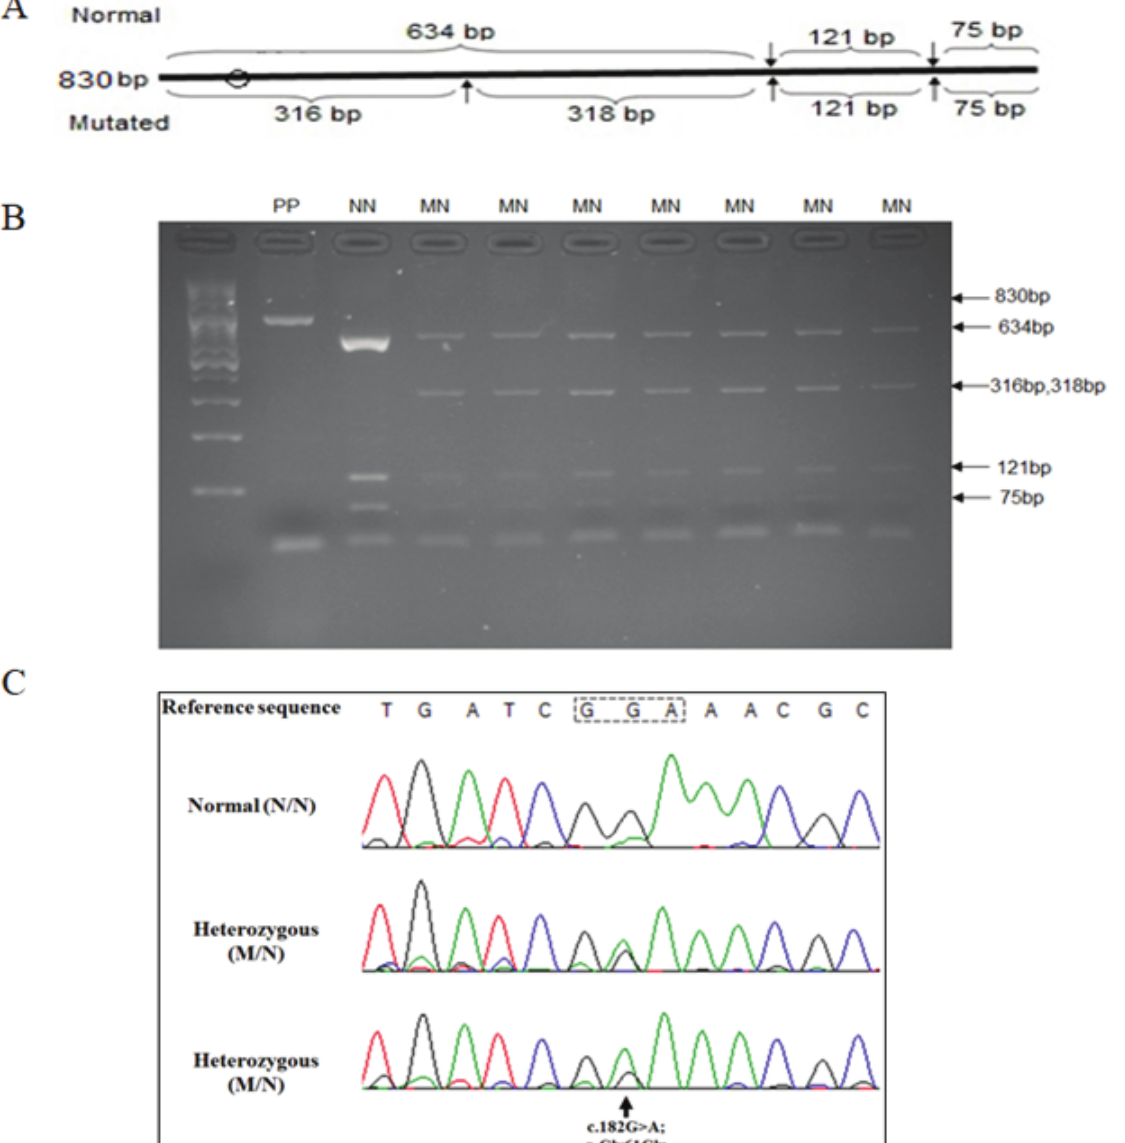
Figure 1. P.Gly61Glu mutation in CYP1B1 caused by the c.182G > A mutation in exon 2 of the encoding gene. (A) Schematic diagram of 830 bp PCR amplicon that includes part of exon 2 of CYP1B1 . Taq 1 restriction enzyme recognition sites in the amplicon containing normal and mutated exon 2 sequences, respectively, are shown by arrows above and below the amplicon. The size of DNA digestion products predicted for the two types of alleles are indicated. The circle shows position of the start of exon 2 within the PCR amplicon. (B) PCR products relevant to screening of p.Gly61Glu. PP, the exon 2 containing PCR amplicon without restriction enzyme treatment; NN, digestion pattern of the amplicon of an individual known to be homozygous for normal sequence; MN, electrophoresis patterns of digestion products of seven of the nine individuals from Talesh who were carriers of the p.Gly61Glu mutation. (C) DNA sequence chromatograms of a wild type CYP1B1 genotype (top) and the heterozygous genotype for the two c.182G > A mutation carriers that causes p.Gly61Glu